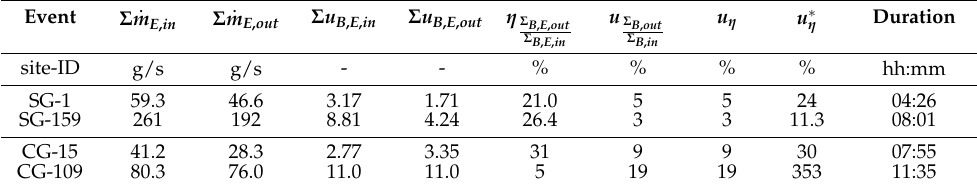
Table 8. Uncertainties for selected events at SG and